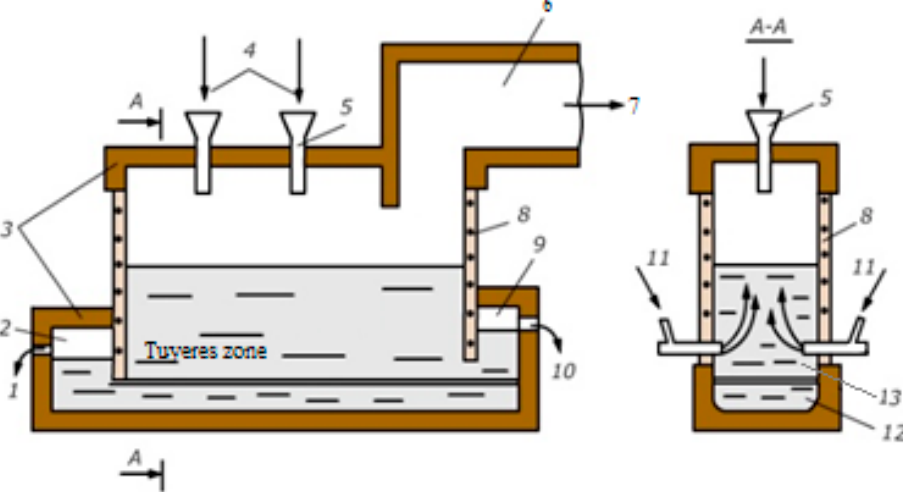
Figure 1. The basic scheme of Vanyukov Furnace. 1—matte release; 2—matte siphon; 3—water- cooling panels; 4—charge; 5—loading funnels; 6—off-gas system; 7—waste gases; 8—copper caissons; 9—slag siphon; 10—slag outlet, 11—tuyeres; 12—matte; 13—slag.